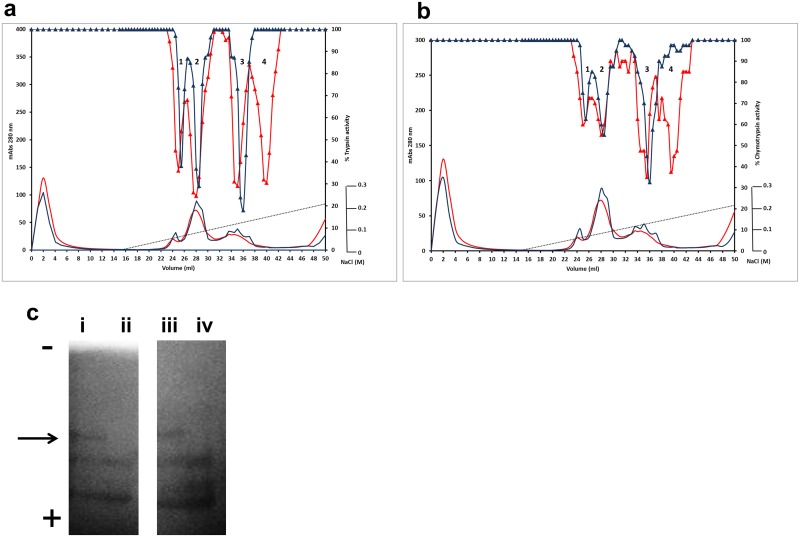
Enzyme inhibitory profile of the TI1 E109K mutation.Seed proteins from wild-type and mutant lines from the TI1 E109K family were separated by cation-exchange chromatography. Absorbance profiles at 280 nm are shown (a, b: red and blue lines without symbols; mAbs, left-hand scale). Using BAPNA and BTEE as specific substrates, the trypsin (a) and chymotrypsin inhibitory (b) activities of wild-type (red triangle) and mutant (blue triangle) protein fractions are shown, relative to assays where trypsin activity is 100% (control; right-hand scale). Numbers in peaks in each chromatogram correspond to the different forms of TI1 and TI2 (peak 1: TI2 processed; Peak 2: TI2 unprocessed; Peak 3: TI1 processed; Peak 4: TI1 unprocessed. (c) in-gel protease inhibitory activity of inhibitor isoforms from wild-type (i, iii) and E109K mutant (ii, iv) lines. Zymogram blue casein gels were treated with the digestive enzymes, trypsin (i, ii) or chymotrypsin (iii, iv); dark areas indicate where the enzyme has been inhibited. The direction of electrophoresis on non-denaturing gels is indicated (-, +). The arrow indicates the position of the isoform that is missing from the mutant lines (tracks ii and iv).